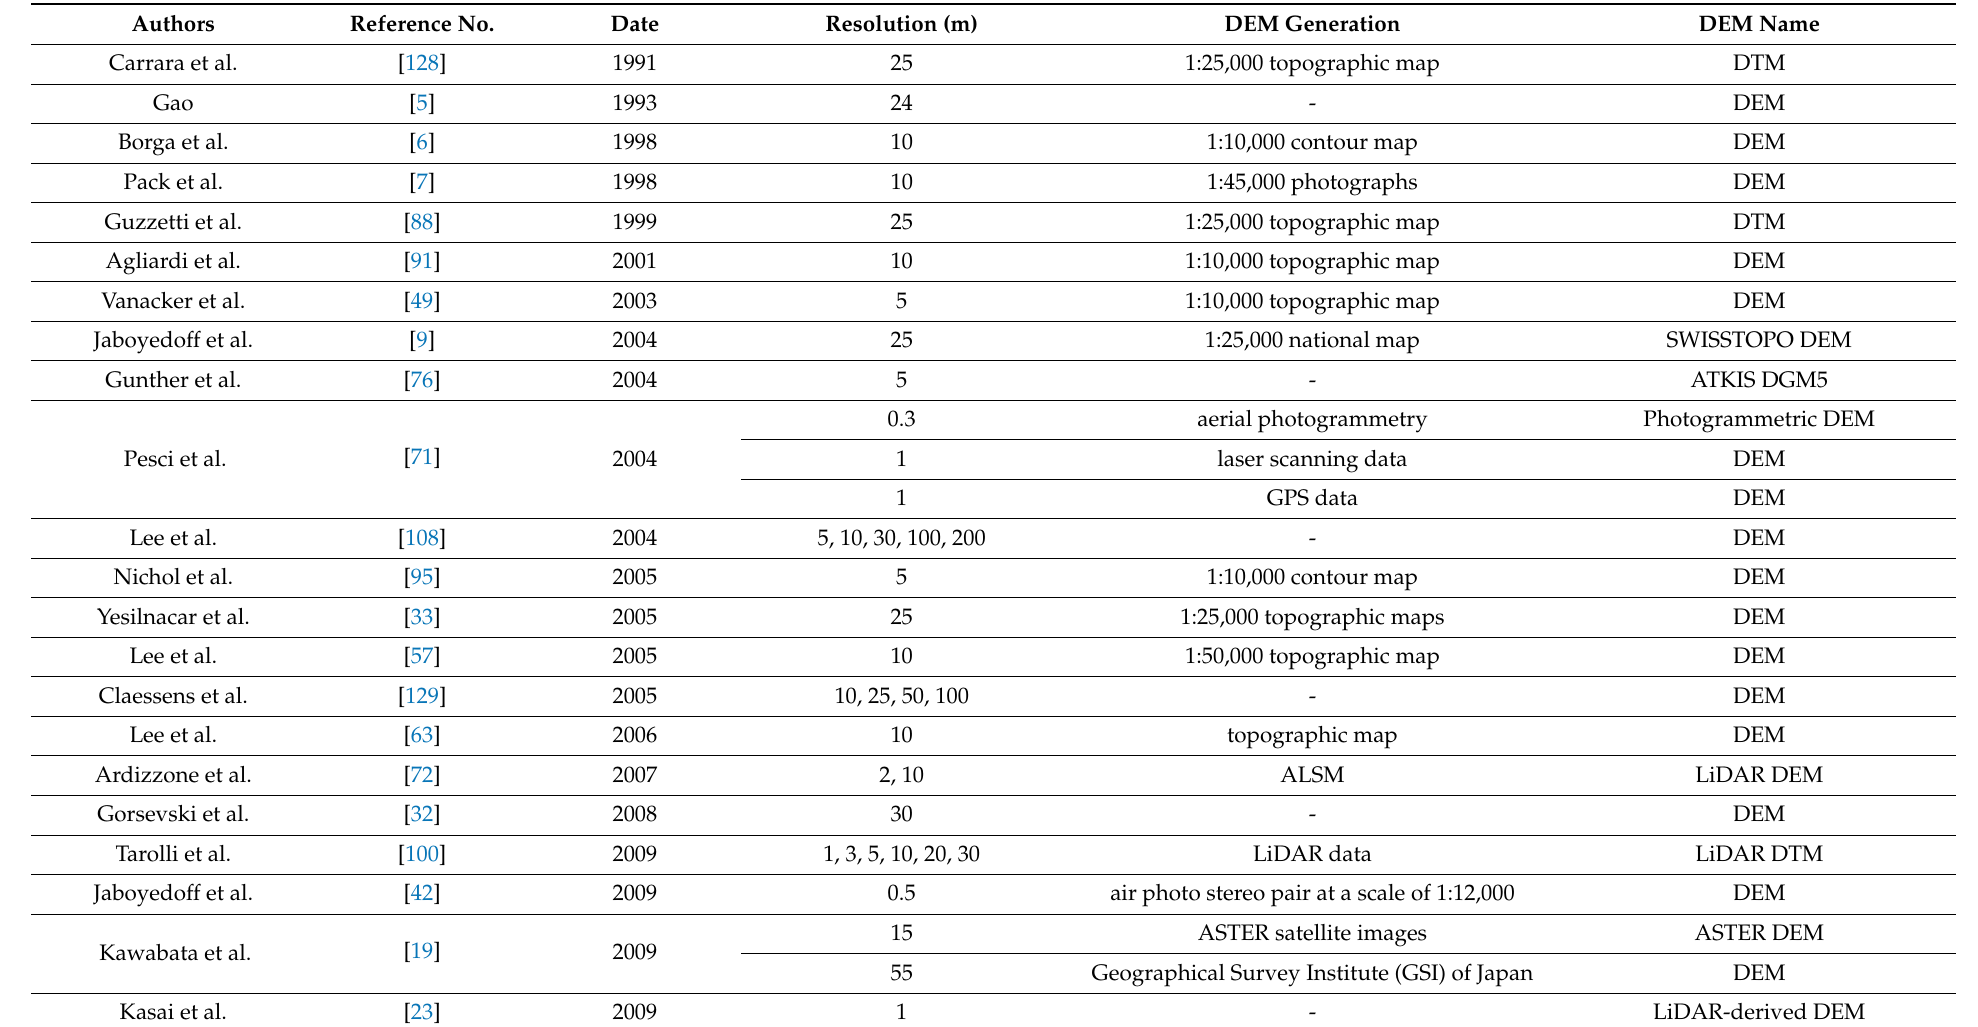
Table 1. Resolutions used in landslide